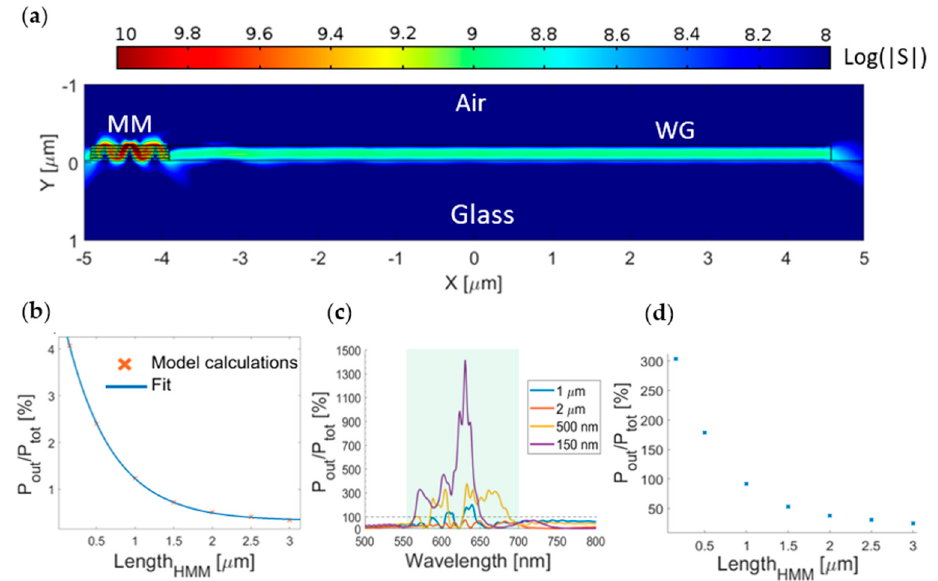
Figure 5. ( a ) Magnitude of the Poynting vector at 637 nm for a 1 µ m long MM coupled with the waveguide. ( b ) Percentage ratio between the total emitted and outgoing power with single exponential dependence on the MM length. ( c ) Global efficiency in the wavelength region of interest for different MM lengths. ( d ) Global efficiency integrated over the highlighted region in ( c ) for different MM lengths.